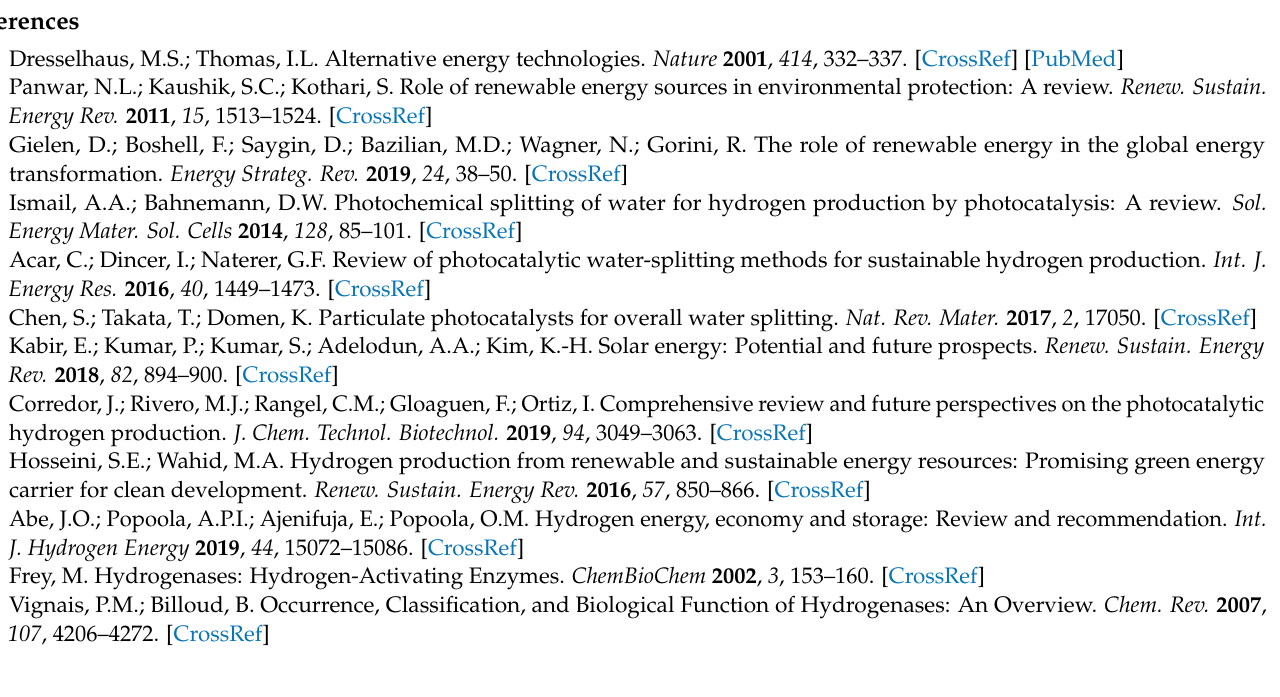
Figure S3: 13 C-NMR and 13 C DEPT-NMR spectra of the FeFeOH diiron complex, Figure S4: 1